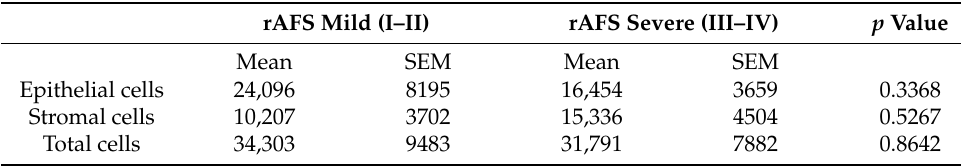
Table 2. Association between rAFS stage and cell numbers.